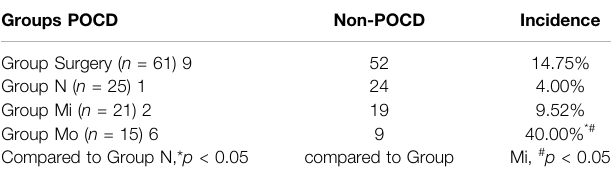
TABLE 2 | Comparison of the incidence of POCD in each